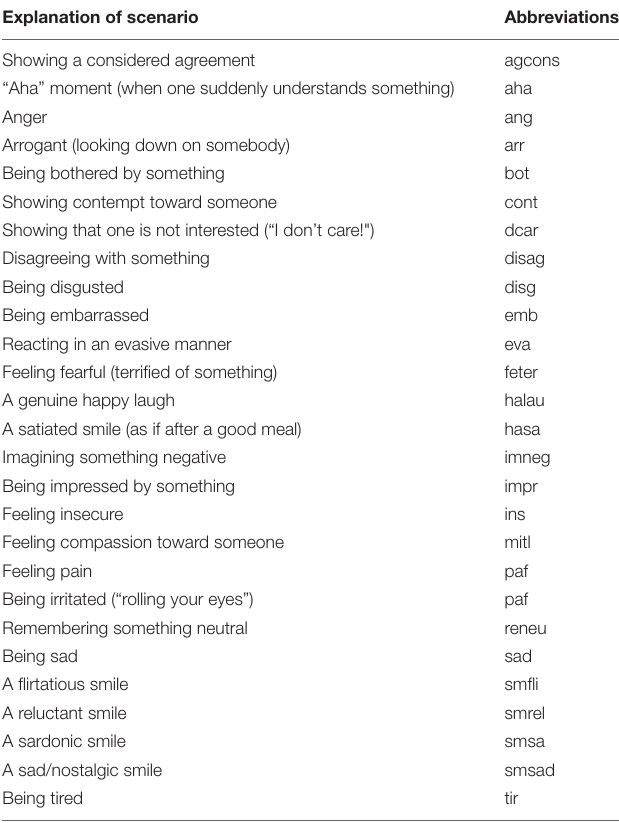
TABLE 2 | Facial expression scenarios used in the present